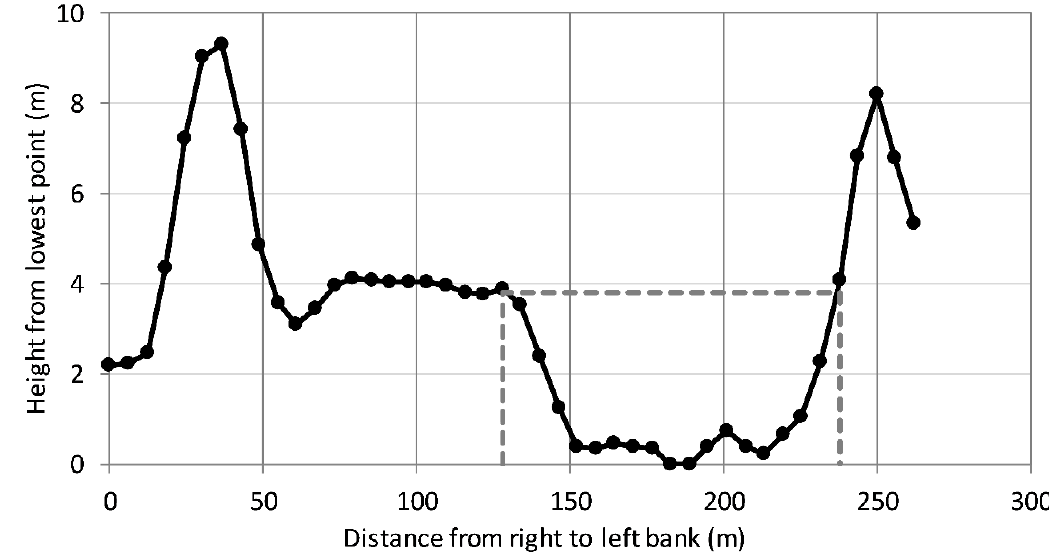
Figure 2. River cross-sectional profile at a point across the Oda river basin. The gray dotted line indicates the river width and depth profile at this point.